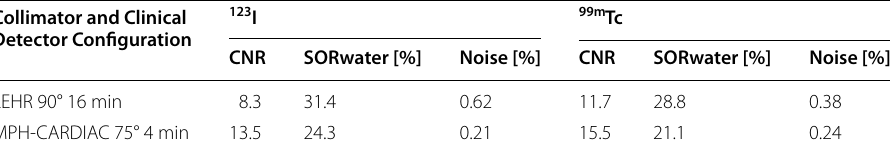
Table 3 SOR and Noise values calculated from ROI analysis of reconstructed SPECT image Polar Maps generated from DataSpectrum LV insert filled with 99m Tc‑sestaMIBI and 123 I‑mIBG measurements on the AnyScan TRIO MPH‑Cardiac and AnyScan SC LEHR systems 123 Collimator and Clinical Detector Configuration